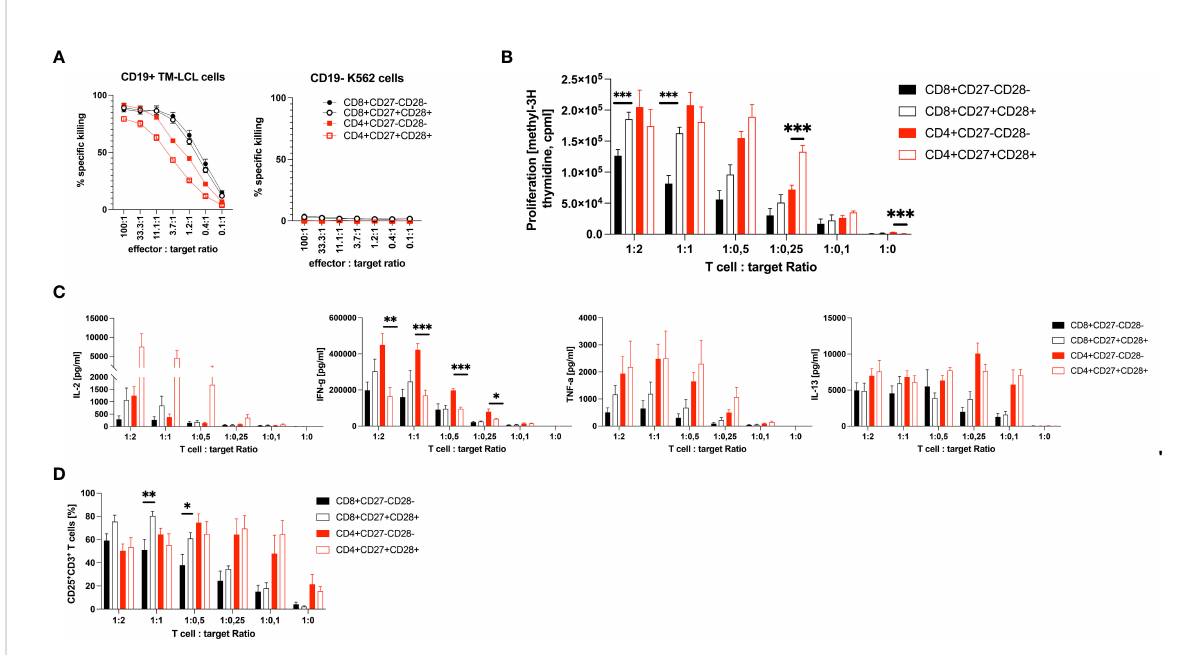
FIGURE 3 Functional comparison of CD3 + CD8 + and CD3 + CD4+ CD27 + CD28 + to CD3 + CD8 + and CD3 + CD4 + CD27 - CD28 - CD19 CART cells in vitro . Shown is (A) the cytotoxic potential as percent speci fi c killing in 5-hour 51 Cr-release assays, (B) the proliferation as count per minutes (cpm) (C) the cytokine production in pg/ml and (D) the percent expression of the high-af fi nity IL-2R (CD25) on CD27 - CD28 - CD3 + CD8 + and CD3 + CD4 + T cells in comparison to CD27 + CD28 + CD3 + CD8 + and CD3 + CD4 + T cells upon co-culture with CD19 + TM-LCL cells. The cytotoxic potential of CD27 - CD28 - and CD27 + CD28 + T cells in (A) is also shown against CD19 - K562 cells. X-axes show the effector to target ratios with either a constant amount of 5 x 10 3 target cells (A) , or a constant amount of effector cells of 1 x 10 5 (B – D) . Data are shown as means plus SEM (whiskers). Numbers of CD19 CAR positive T cells were 91.5 ± 0.1% and 96.0 ± 0.3%, respectively. Data show the summary of three (A , D) or four (B , C) independent experiments with three different donors in biological triplicates for CD8 + T cells, except one donor in duplicates for Cytotoxicity tests, and two independent experiments with two different donors in biological triplicates for CD4 + T cells. *P < 0.05, **P < 0.01, ***P < 0.001 as determined by unpaired Student ’ s